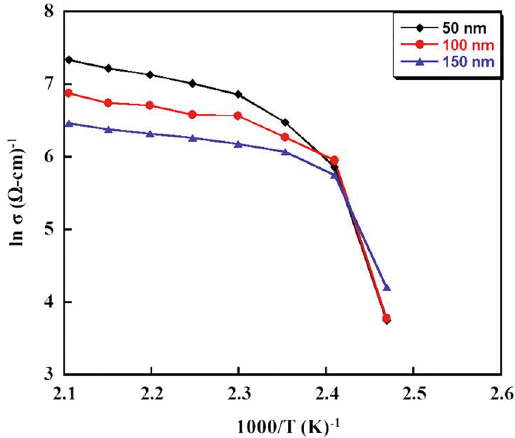
O thin films with 2 3